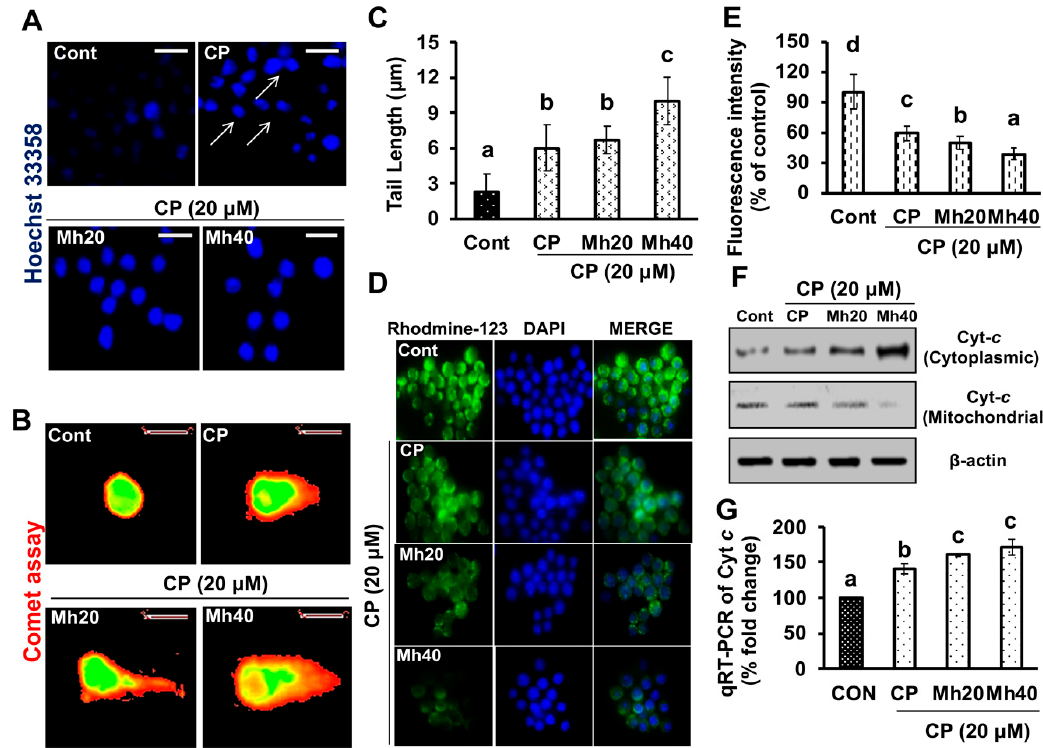
Figure 3. Effect of CP and CP-Mh on cellular apoptosis. ( A ) HepG2 cells were stained with the Hoechst-33342; condensed and fragmented nuclei indicated by arrows. ( B ) DNA damage evaluated by comet assay; images were captured by fluorescence microscope (magnification 400×, scale 0.1 mm). ( C ) Graphical representation of comet tail length. ( D ) Mitochondrial membrane potential disruption in HepG2 cells was assayed by Rhodamine-123 green stain after corresponding drug treatment and visualized by fluorescence microscopy (scale bar 0.1 mm). ( E ) Fluorescence intensity of Rhodamine-123 stain measured using ImageJ software. ( F ) Expression levels of the major mitochondrial apoptosis markers Cyt c was analyzed in the cytosolic and mitochondrial fraction proteins by Western blotting. β -actin was used as an internal control. ( G ) Quantitation of Cyt c mRNA level by quantitative real time-polymerase chain reaction (qRT-PCR) after corresponding drug treatment in HepG2 cells. The data are represented as the means standard deviation (±SD, n = 3). The values of different letters (a–d) differ significantly from each other ( p < 0.05).